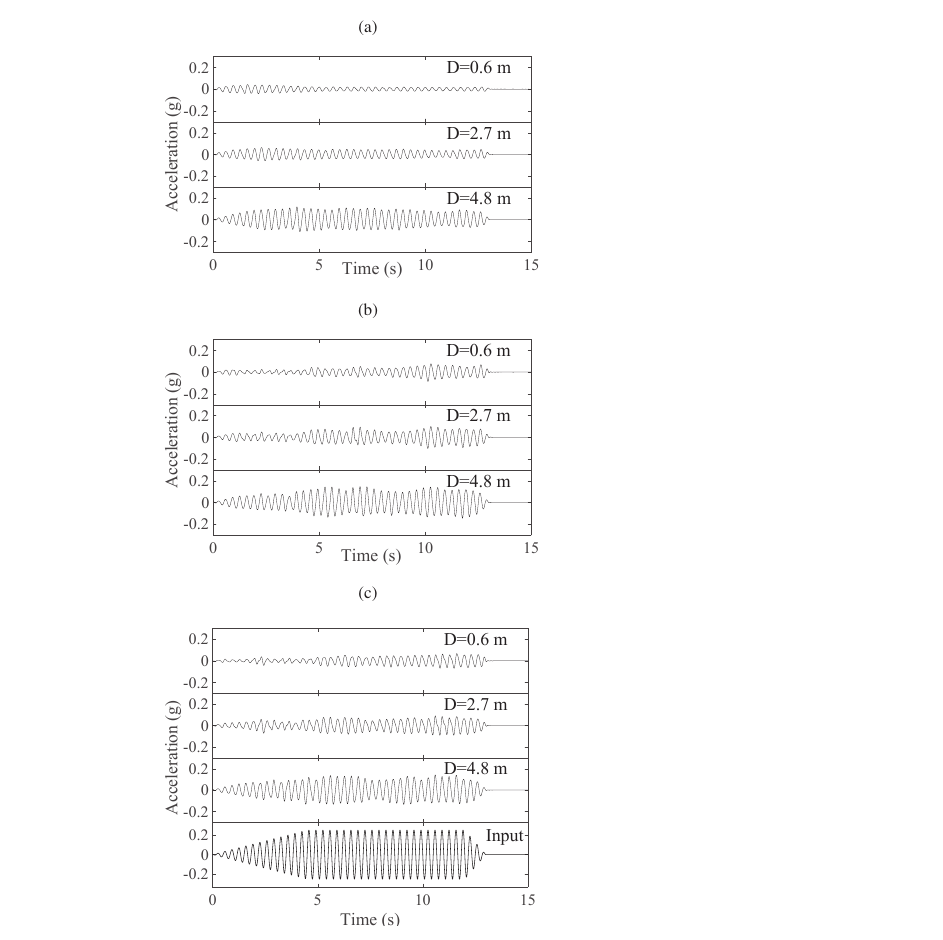
Figure 13. Acceleration time histories at selected depth locations for soil deposits with different degrees of saturation ( a ) Fully saturated, ( b ) S = 92% and ( c ) S =